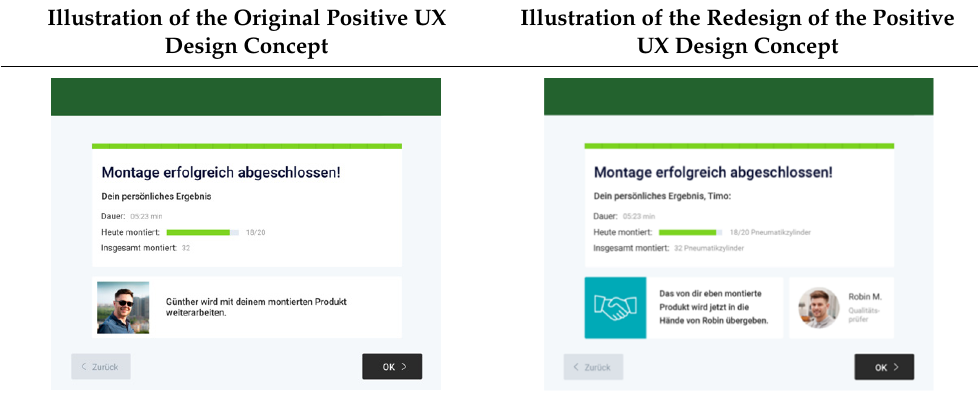
Table 8. Original positive UX design concept and respective redesign of “Passing on to a colleague”. Illustration of the Original Positive UX